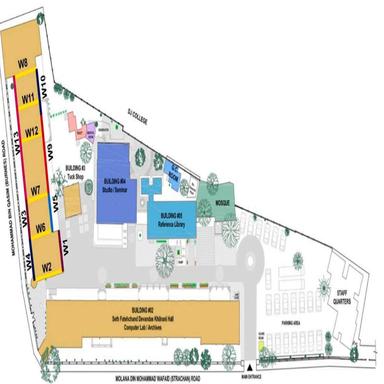
Map of City Campus Building along with the location of Walls.